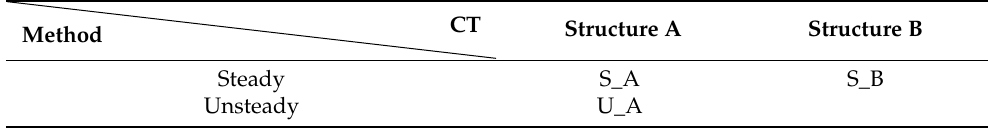
Figure 2. Casing-treatment structures with circumferential grooves. Table 1. Notations of the numerical models with/without